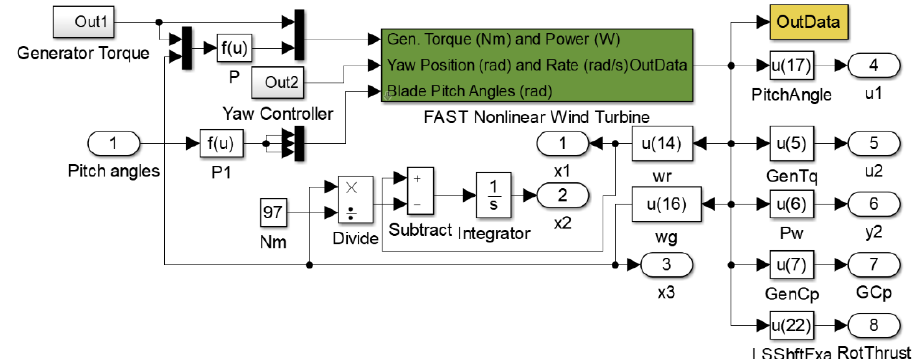
Figure 14. The Simulink interfacing scheme combined with FAST block. Under the mean wind speed sequence